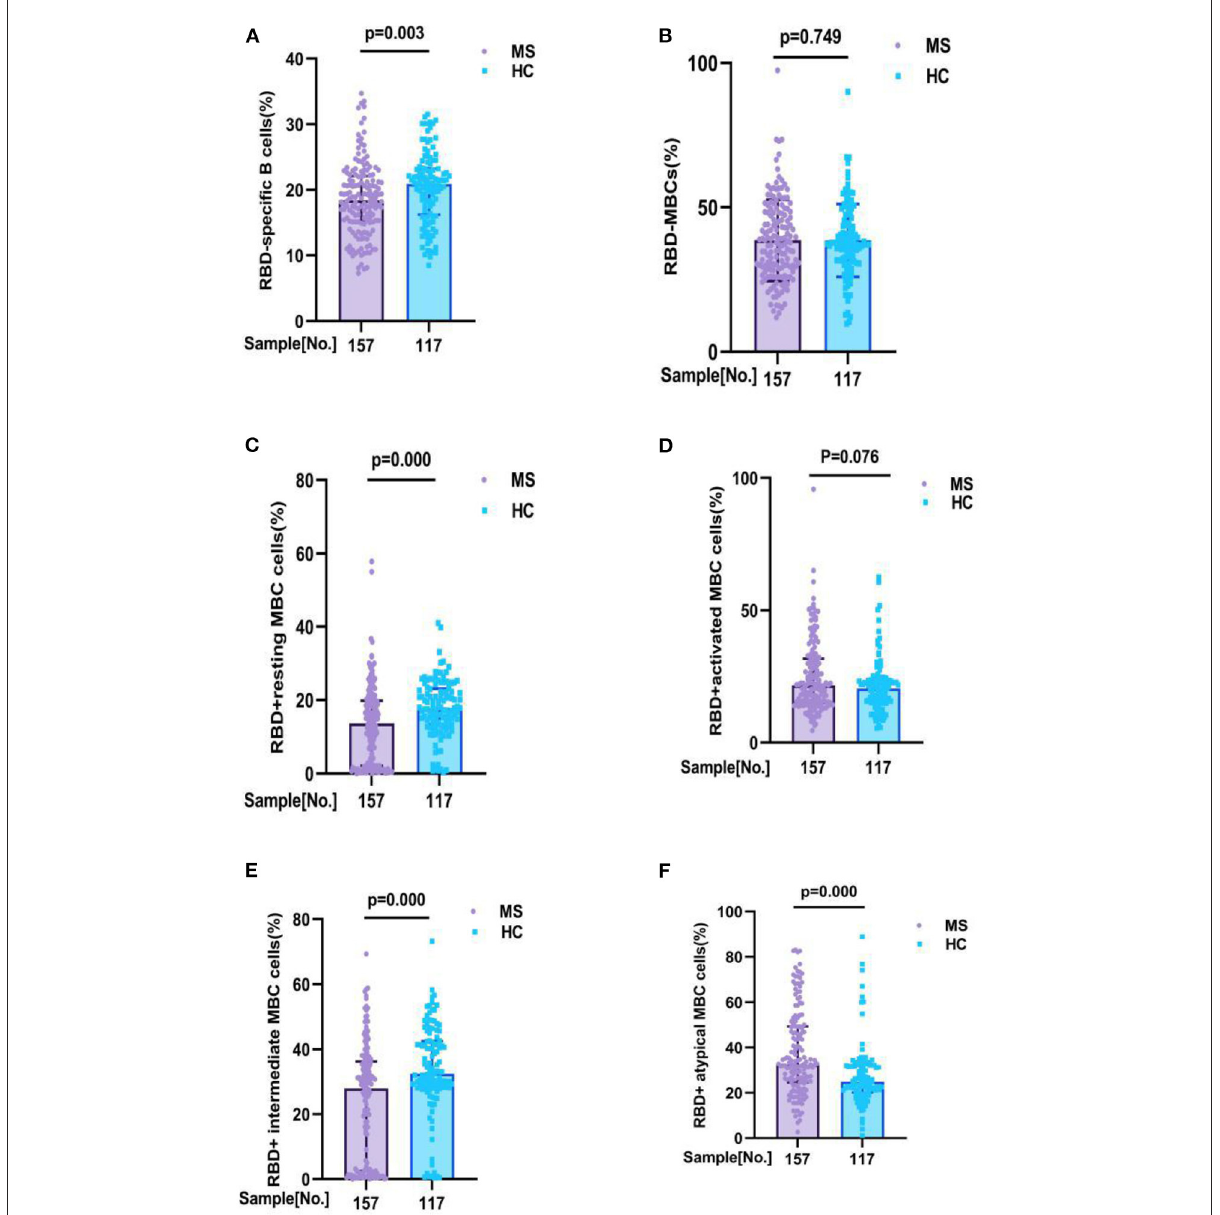
FIGURE2 RBD-specific B cells response to inactivated COVID-19 vaccines in participants with MS and HC. Comparisons of the RBD-specific B cells in all participants, MS patients had lower frequencies of (A) RBD - specific B cells (18. 42v s. 20.90%, p = 0.003), (C) RBD + resting MBCs (13.60 vs. 17.80%, p = 0.000), and (E) RBD + intermediate MBCs (27.90 vs. 32.40%, p = 0.000) than HC, and had a higher frequencies of (F) RBD + atypical MBCs (32.37 vs. 24.70%, p = 0.000) than HC. But no significant difference was found in the frequencies of (B) RBD-specific MBCs (37.80 vs. 37.70%, p = 0.749), (D) RBD + activated MBCs (21.56 vs. 20.40%, p = 0.076), between MS patients and HC participants (data are shown in Supplementary Table 1B).